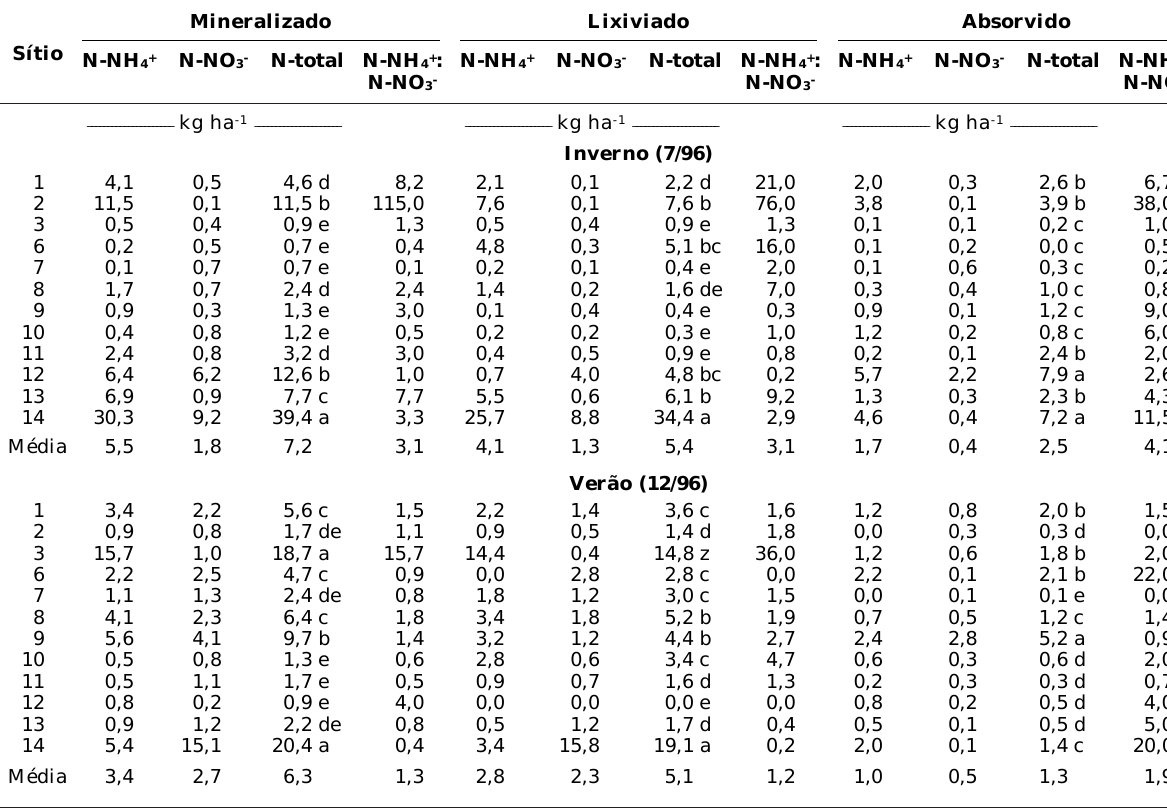
Quadro 6. Quantidades médias de N-NH 4+ e N-NO 3- (mineralizado, lixiviado e absorvido) e